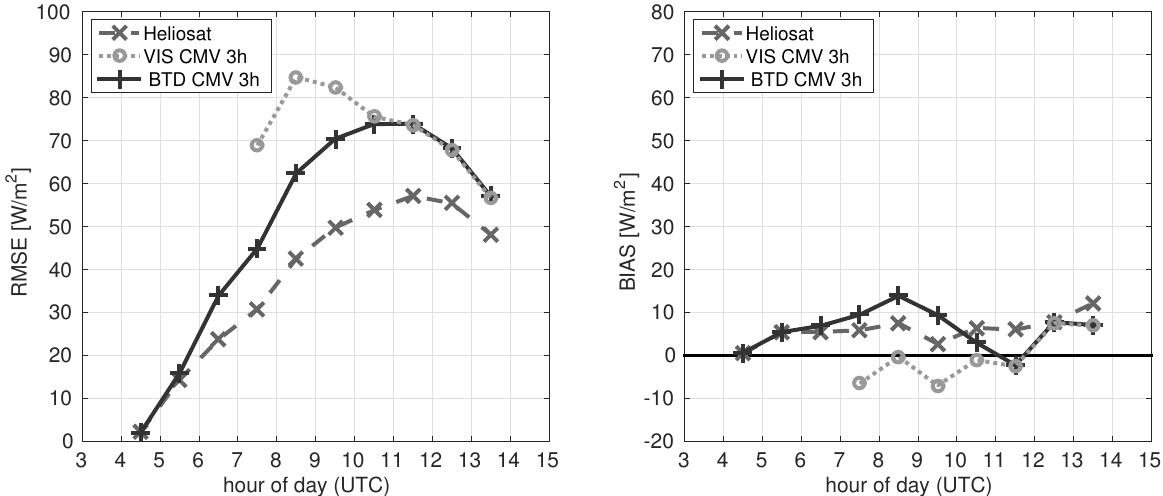
Figure 11. Hour-dependent error for CMV two- to three-hour forecasts with origin before noon, evaluated for all stations in the